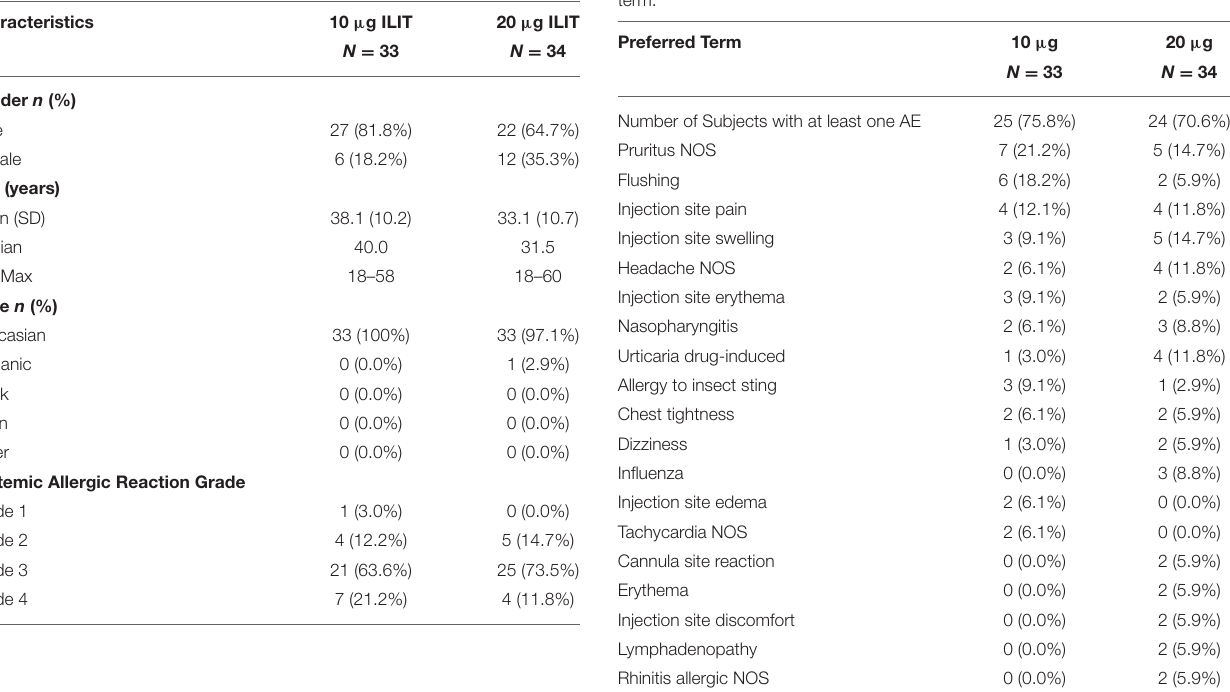
TABLE 2 | Adverse events (AEs) in the safety population (reported for ≥ 5% of subjects in either treatment groups) during the treatment period by the preferred